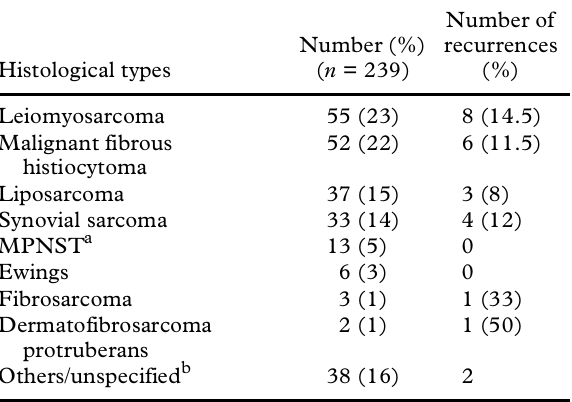
Table 2. Histological profile of total patients treated